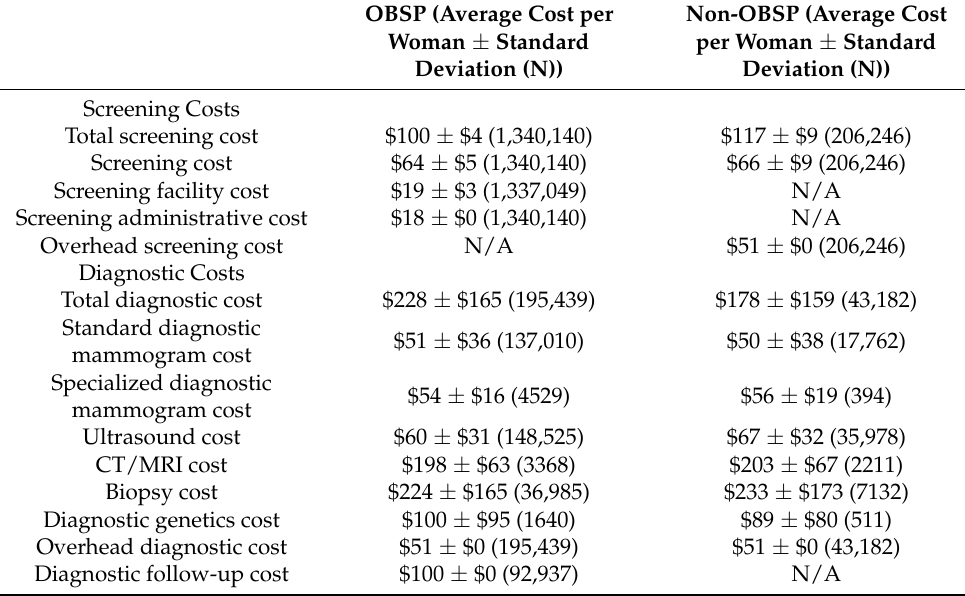
Table 2. Screening and Diagnostic Components for OBSP and Non-OBSP Cohort.